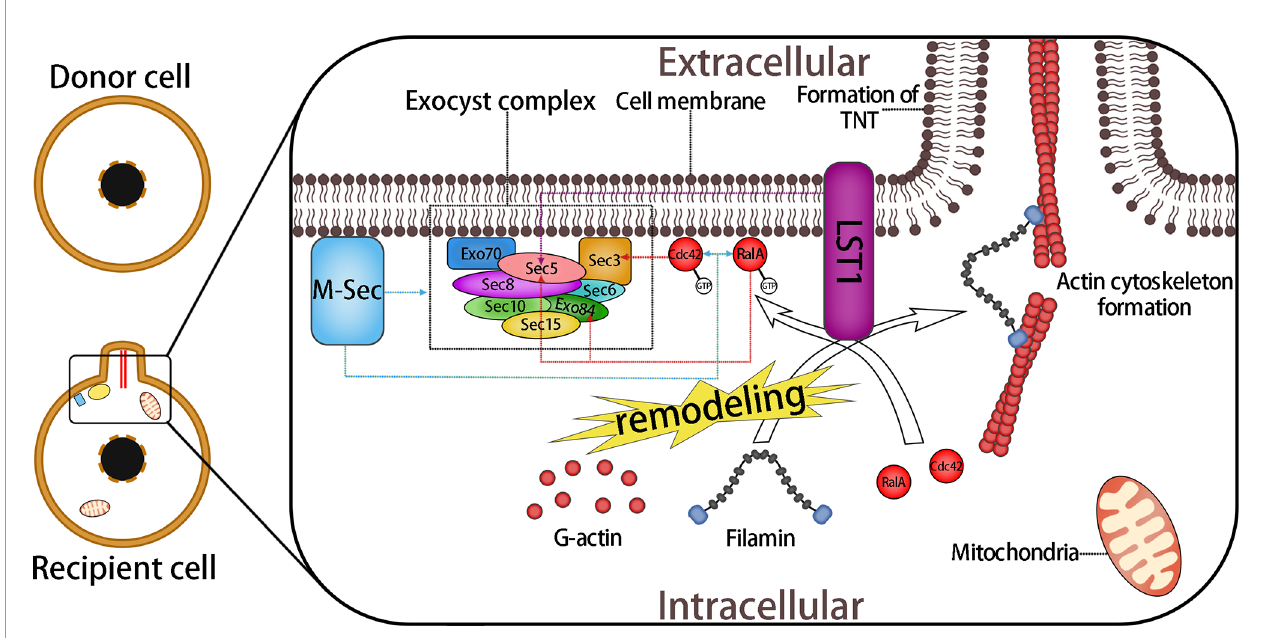
FIGURE 3 | Formation of TNTs Mediated by M-Sec and the Exocyst Complex. The exocyst complex consists of eight proteins: Sec3, Sec35, Sec36, Sec38, Sec310, Sec315, Exo70, and Exo84. During the interactions of M-sec with the exocyst complex, small GTPase RalA and Cdc42 promote the assembly of the exocyst complex and lead to the remodeling of actin. Active RalA (RalA-GTP) interacts with two components of the exocyst complex, Sec5 and Exo84, which bind to RalA competitively. This interaction leads directly to the aggregation of G-actin and the subsequent formation of the membrane protrusion. The combination of Cdc42 and Sec3 plays a role in the prolongation stage of the membrane protrusion. In addition, LST1 recruits RalA to the submembrane region, and promotes its interaction with the exocyst complex and recruits fi lamin, an actin cross-linked protein. Moreover, LST1 can interact with M-sec, myosin, and myoferlin, which might also participate in the subsequent process of mitochondrial anchoring and transfer. Overall, a variety of molecules are involved in the formation of the membrane protrusion, including some of the molecules mentioned later. Together, they form a multi-molecular complex that regulates the formation of TNTs. Dotted arrows indicate interactions between